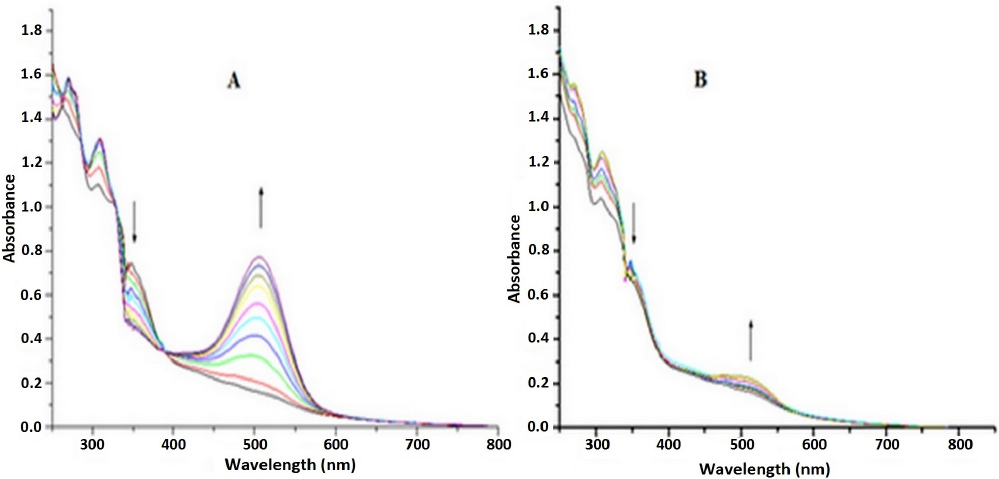
Figure 4. Spectral variation in Ru ‐ NO complex in HEPES buffer (pH 7.4) after each 20 s laser irradiation at ( A ) 355 nm and ( B ) 532 nm. at ( A ) 355 nm and ( B ) 532